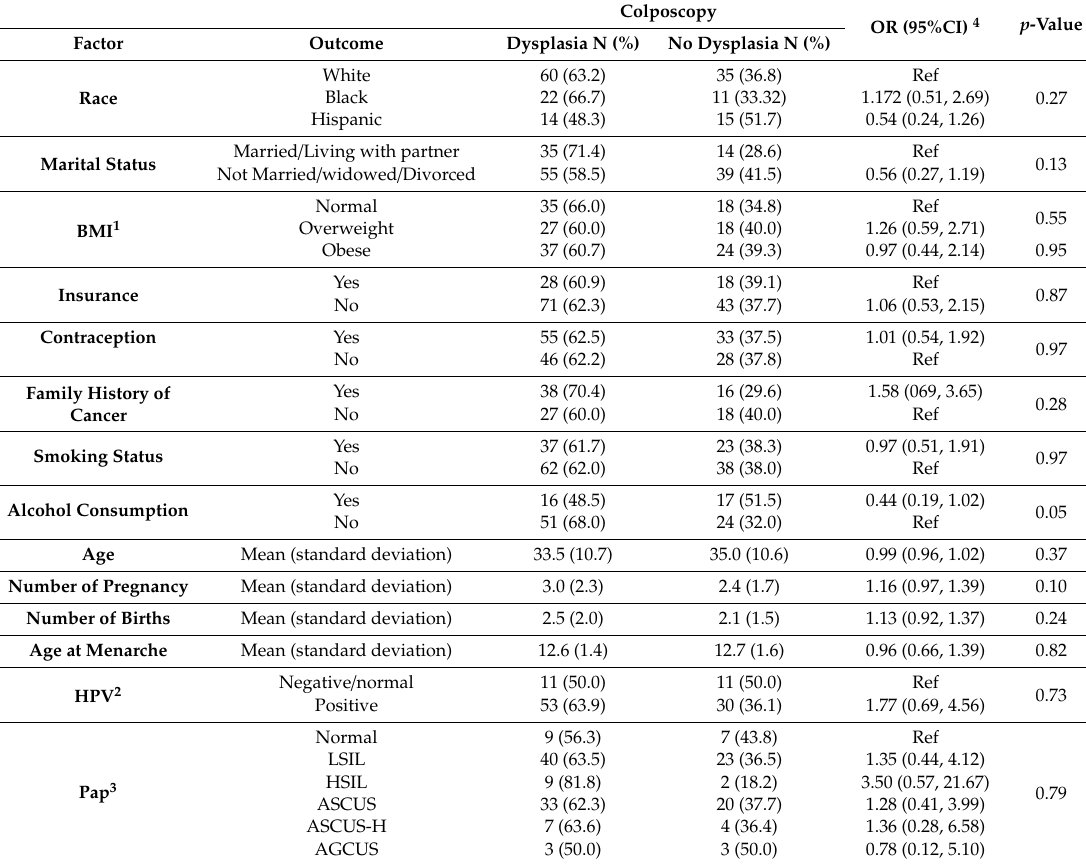
Table 3. Association between outcome from colposcopy and HPV status, Pap test results and socio-demographic